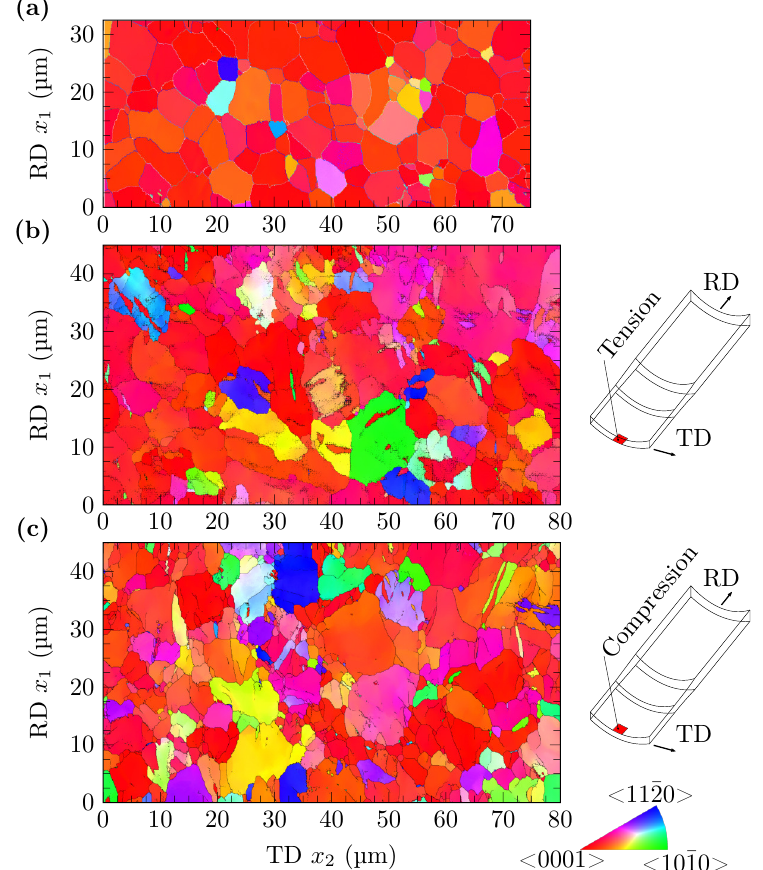
Figure 4. EBSD orientation maps with a view in the ND: ( a ) the as-received material with a scanning step of 0.085µm; ( b ) the hot-bent material of the tension layer; ( c ) the compression layer. The scanning step of the EBSD maps of the hot-bent material from the tension layer and the compression layer is 0.07µm and 0.045µm,